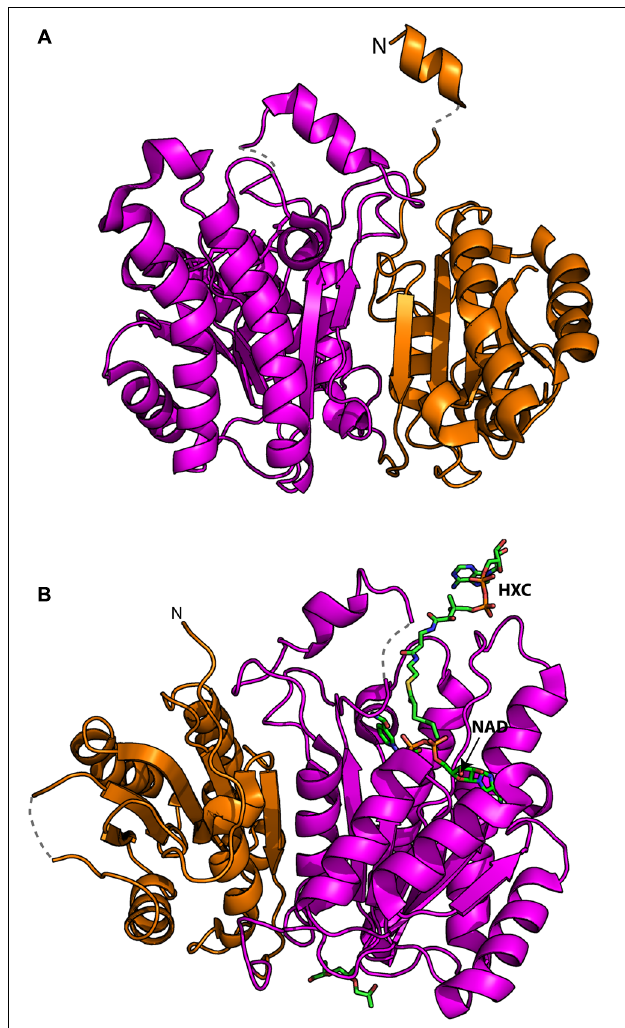
FIGURE 1 | Crystal structures of FabG4: (A) N-terminal “flavodoxin type” (orange) and C-terminal ketoreductase (magenta) domains. “N” indicated the N-terminal of the polypeptide chain. The regions those were not be traced in electron density are shown in dotted lines. (B) The substrate mimic hexanoyl coenzyme A (HXC) and NAD + bound structure shows the putative substrate binding